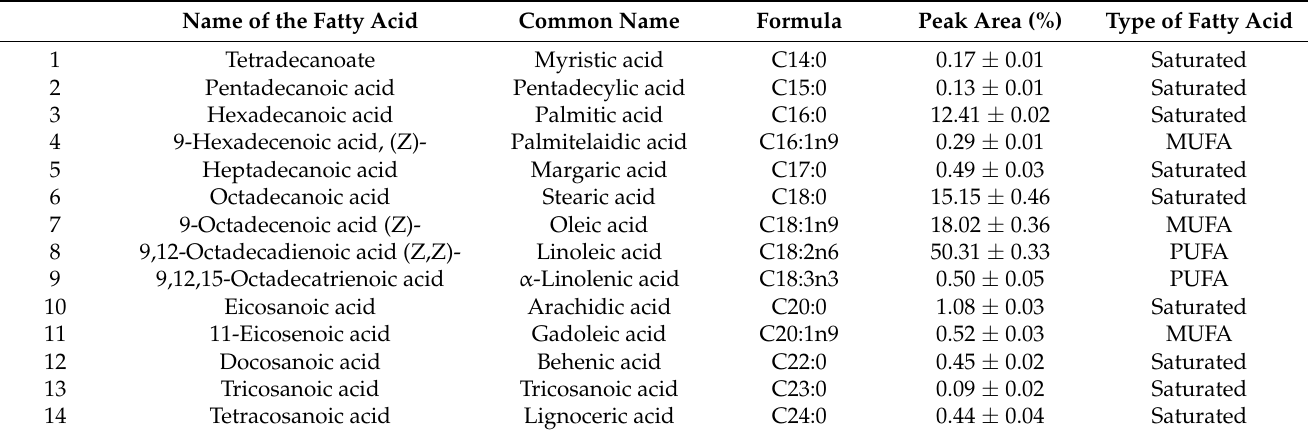
Table 1. The fatty acid composition of tumba ( Citrullus colocynthis L.) seed oil obtained in the present